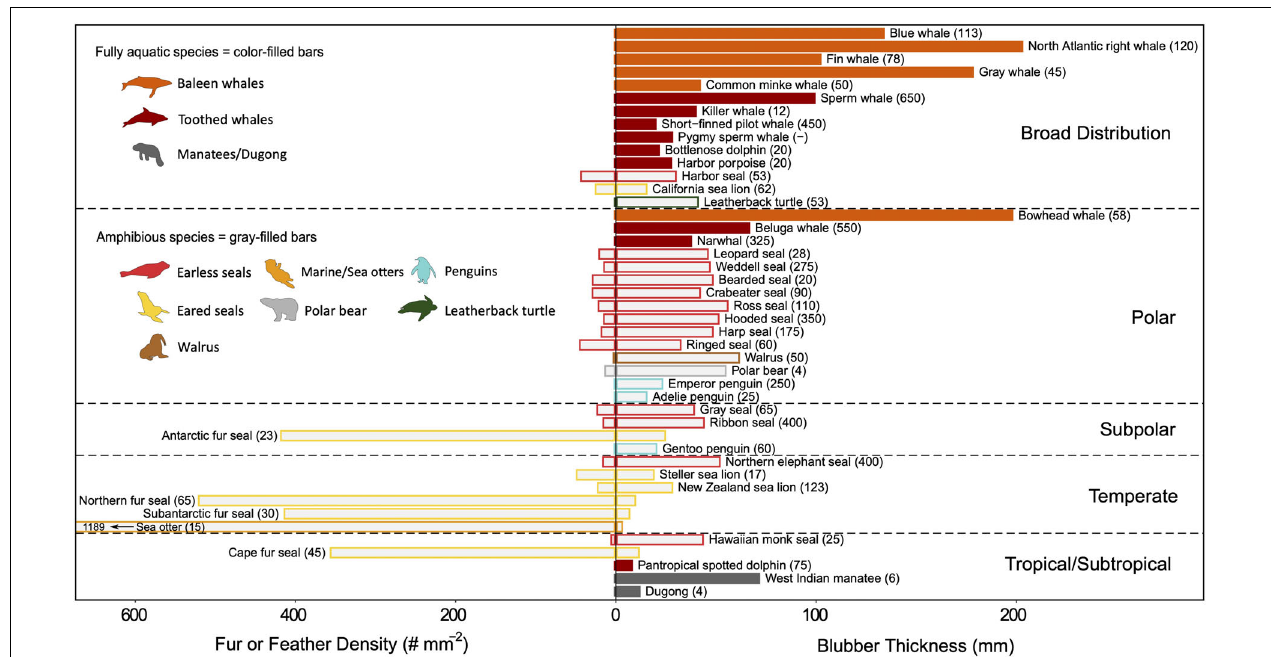
FIGURE 7 | A comparison of the quantity of external and internal insulation among marine divers that occupy different habitat ranges. Species were included for which both fur/feather density (number of hairs/feathers per mm 2 ) and blubber thickness (mm) are known (values represent whole-body averages, i.e. not site-specific). It was assumed that cetaceans and sirenians have lost all insulating hair. Within each habitat range, species are grouped by family and ordered by increasing mass along the vertical axis. Routine dive depth (meters) is indicated in parentheses for each species. Fully aquatic species (color-filled bars) rely exclusively on blubber, whereas amphibious species (gray-filled bars) that retain both forms of insulation vary in which layer is most effective. The primary insulation layer for the species is indicated by whether the species common name is written on the fur/feather or blubber side of the graph. Amphibious species with broad distributions (i.e., species that span more than one habitat range) use blubber as their primary insulation layer. With the exception of the Antarctic and Cape fur seals, those that rely on fur as their primary insulation are found in temperate zones, but a gradient of morphological adaptations is seen in this region. Few data exist on feather densities, which are orders of magnitude smaller when compared to fur densities. Moreover, while contour feather density is generally reported, plumule feathers provide greater insulation and are present at higher densities. Refer to Supplementary Table S1 for absolute latitudes used for determining habitat range and Supplementary Table S3 for insulation layer properties data